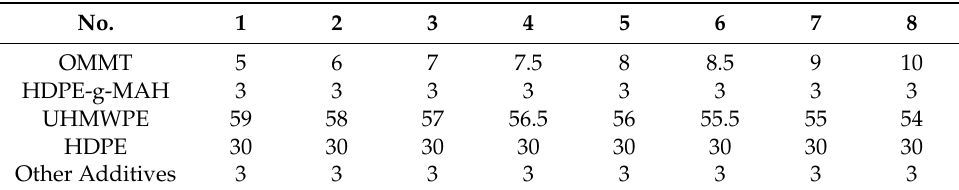
Table 3. Mass fraction of each component /